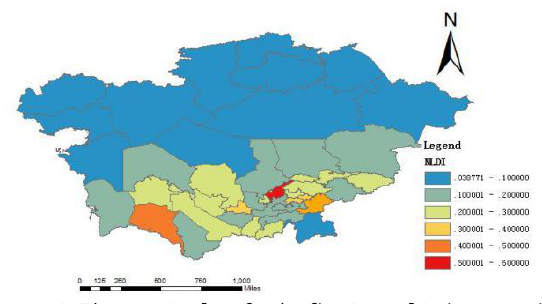
was drawn as shown in Figure 13.